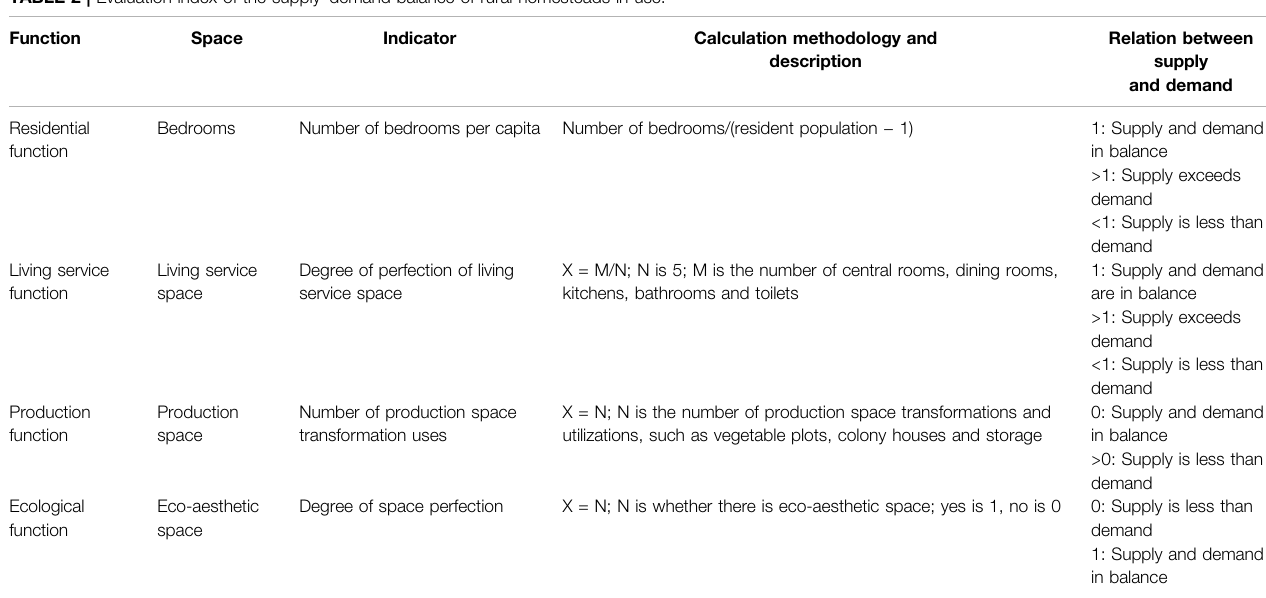
TABLE 2 | Evaluation index of the supply – demand balance of rural homesteads in